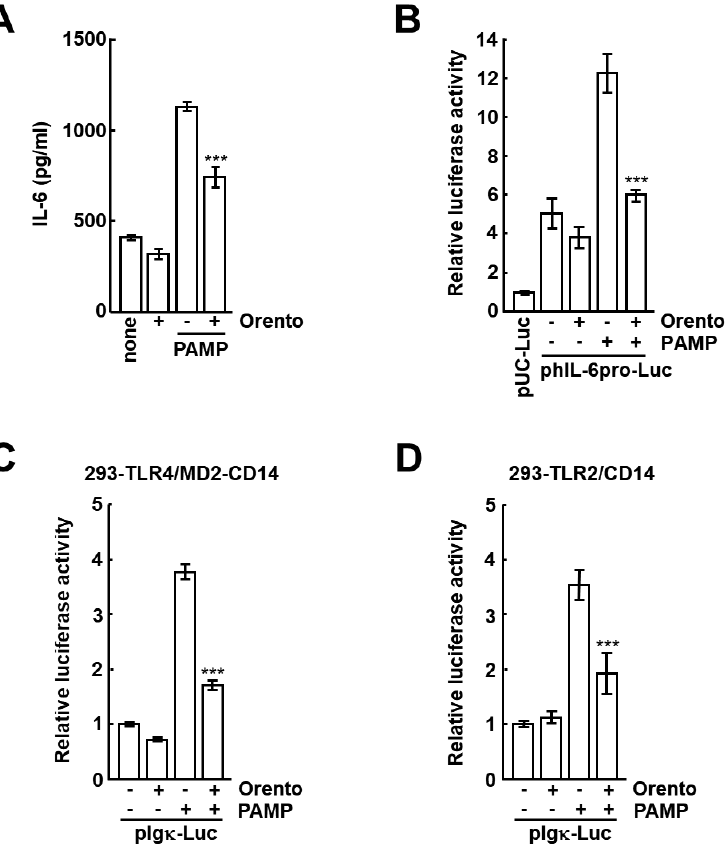
Figure 2. The effects of orento on increase in IL-6 production and the activation of its promoter by PAMP in CAL27 cells. The protocols are described in Section 4. ( A ) Orento and PAMP were added to the culture media of CAL27 cells, and the levels of IL-6 in the culture media were measured by ELISA. ( B ) A reporter plasmid containing the IL-6 promoter linked to the luciferase gene (phIL-6pro- Luc) and a standard plasmid (pRSV- β -gal) were co-transfected into CAL27 cells. ( C , D ) Inhibitory effects of orento on PAMP-stimulated NF-kB-dependent transcriptional activation. pIg κ -Luc and pRSV- β -gal were co-transfected into 293-TLR4/MD2-CD14 and 293-TLR2/CD14 cells. The cells were stimulated with PAMP (100 ng/mL) for 6 h in the presence of orento (1000 µ g/mL). Luciferase and β -galactosidase assays were performed. The transcriptional activities were indicated as fold values of those of pUC-Luc (a plasmid containing luciferase gene alone) ( B ) and of pIg κ -Luc (without orento and PAMP stimulation) ( C ). Bars represent the means and range of triplicate samples. ***, p < 0.001 versus stimulation with PAMP without